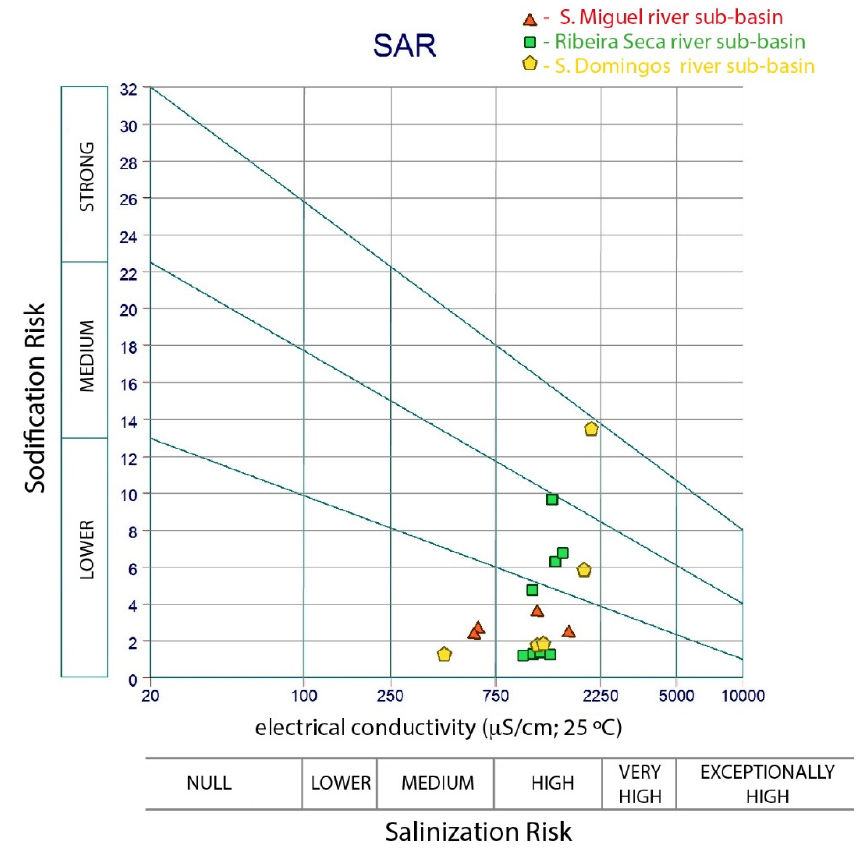
Figure 14. Soil salinization and sodium absorption risk (SAR diagram)—S. Miguel, Ribeira Seca and S. Domingos river sub-basins.